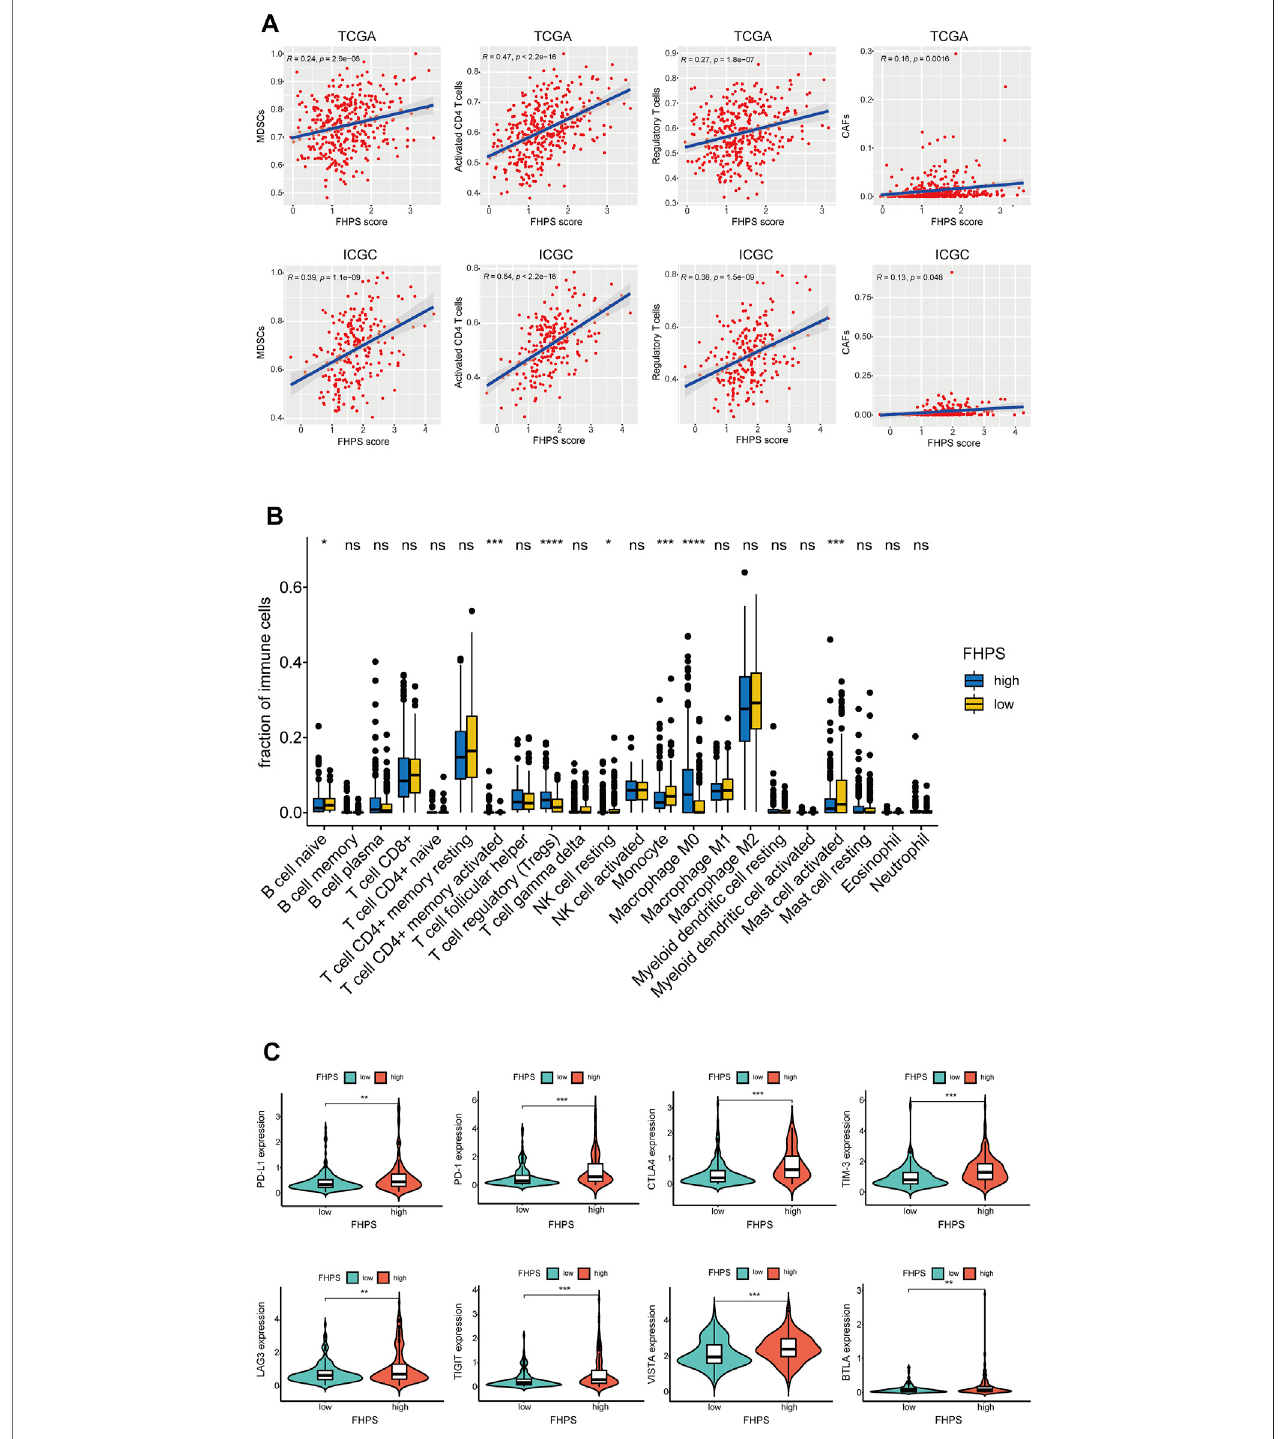
FIGURE6|(A) ssGSEA andcorrelation analysisoftheFHPSscoresandtheimmuneenrichmentscoresofimmunecategoriesintheTCGAandICGC cohorts. (B) Comparison between the fractions of immune cells in the high- and low-FHPS groups of the TCGA cohort via the CIBERSORT method. (C) Comparison between the expression of several prominent immune checkpoints in the high- and low-FHPS groups of the TCGA cohort. * p < 0.05; ** p < 0.01; *** p < 0.001; **** p < 0.0001.